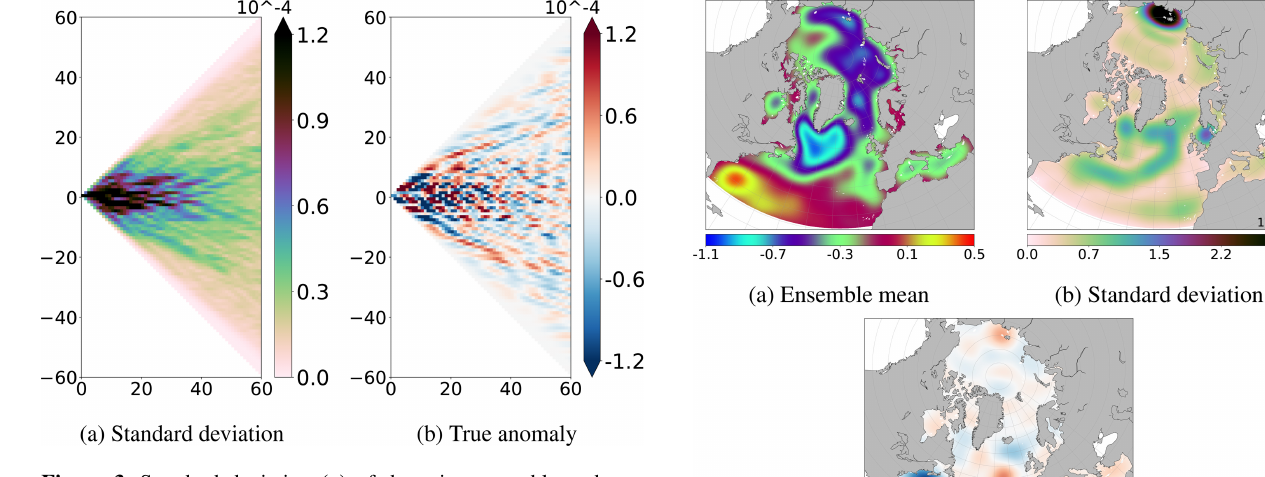
Figure 3. Standard deviation (a) of the prior ensemble and true anomaly (b) in the spectral domain (SSH), according to the degrees l ∈ [ 0 , 60 ] in the abscissa and m in the ordinate; see Eq. (2), which corresponds to a characteristic scale larger than L ≈ 106km.